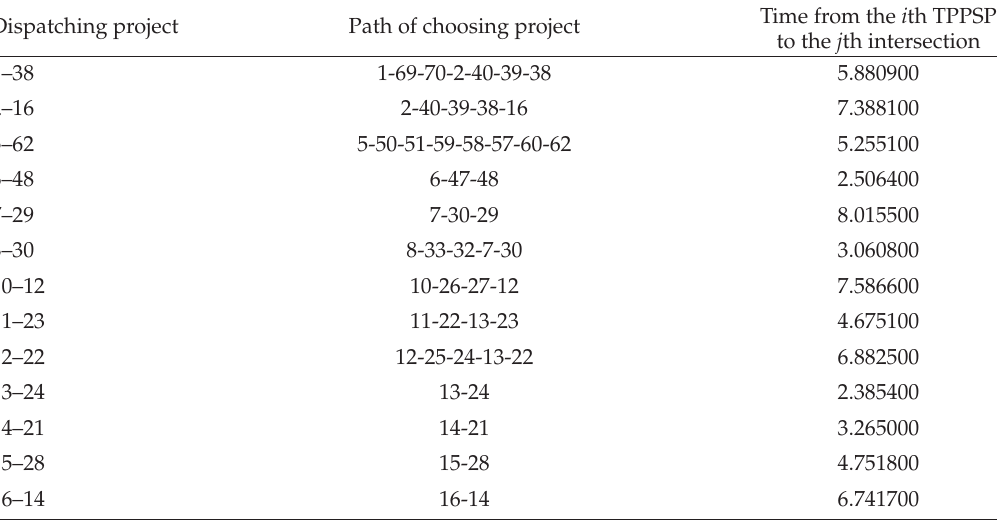
Table 3: The optimal dispatch project of TPPSP with T pq (cid:8) 10min.